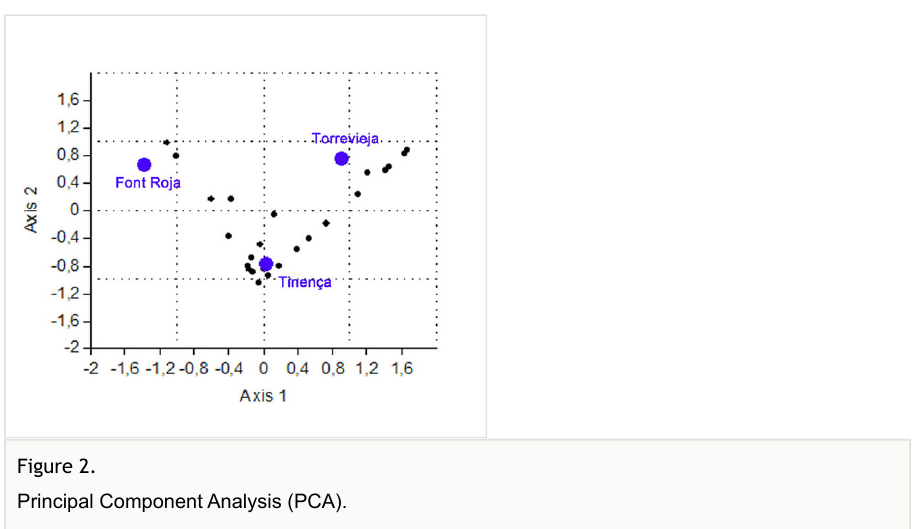
However, applying the Principal Component Analysis (PCA) (Fig. 2) shows that there are many unique species to each Natural Park (16 for Tinença, 7 for Torrevieja and 6 for Font Roja) while the rest of species are usually present shared (17 for Font Roja-Tinença, 12 for Tinença-Torrevieja and 7 for Font Roja-Torrevieja). This could be due to the fact that Tinença and Font Roja are Mediterranean forests while Torrevieja is a lagoon.